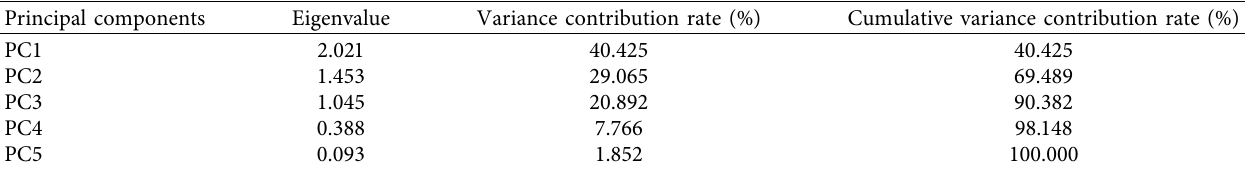
Table 3: Eigenvalues and variance contribution rates of related